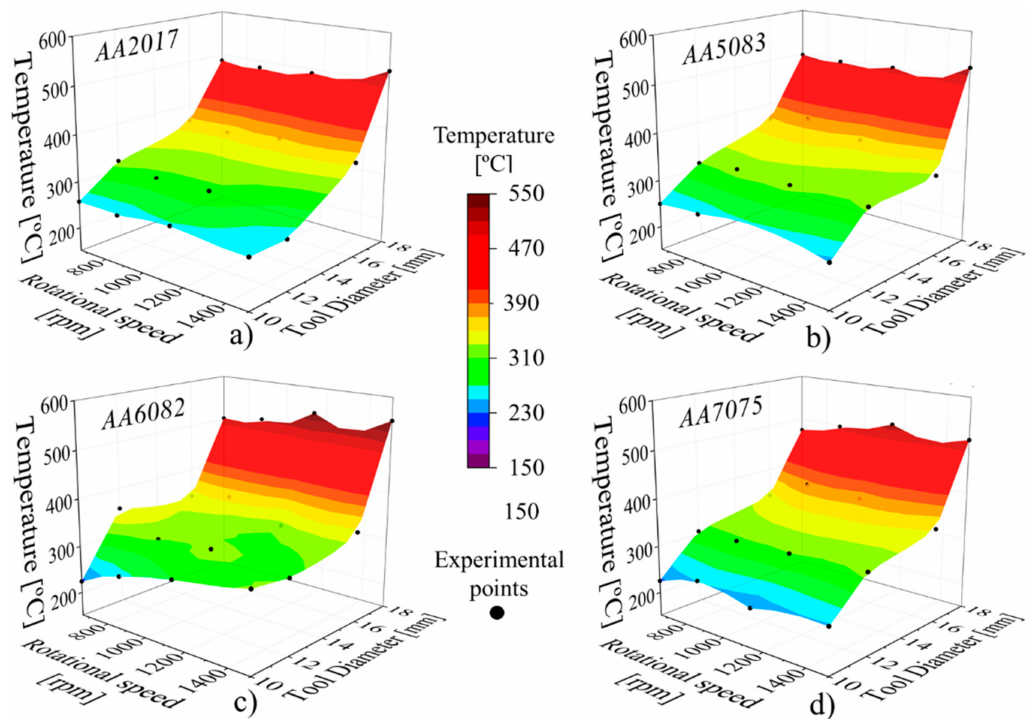
Figure 7. Evolution of the temperature values with the rotational speed and tool diameter for the ( a ) AA2017, ( b ) AA5083, ( c ) AA6082 and ( d ) AA7075 aluminium